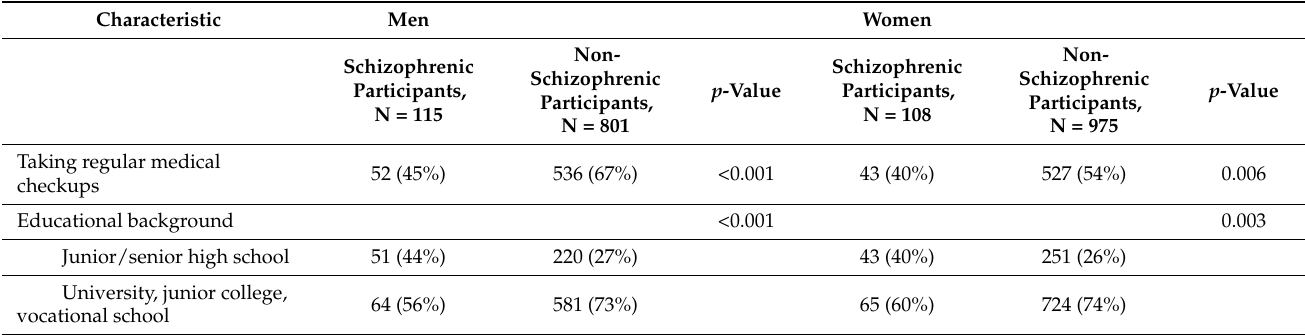
Table 4. Social comorbidities of participants with schizophrenia and participants without schizophre- nia according to